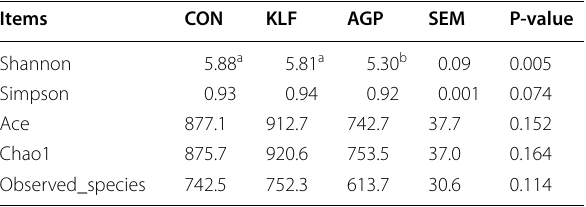
Table 5 Effects of Kudzu-leaf flavonoids supplement on α- diversity of cecal contents bacterial communities